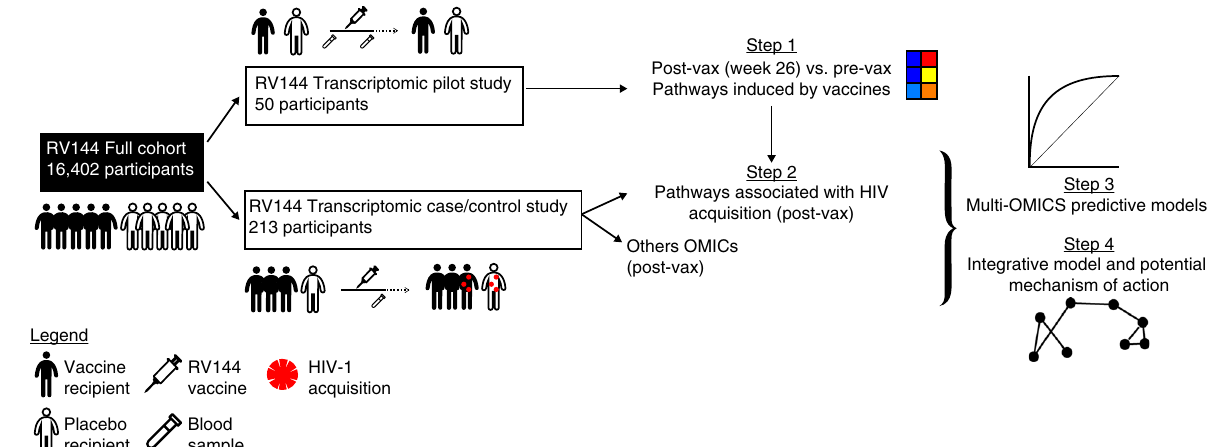
Fig. 1 Study overview. Four analysis steps were used to identify transcriptomic markers of risk of HIV-1 acquisition among RV144 vaccinees. A fi rst transcriptomic dataset of blood collected from 40 HIV-1 negative vaccinees and 10 HIV-1 negative placebo recipients prevaccination and 2 weeks after vaccination was used to identify pathways modulated by the RV144 vaccine (step 1). A second independent transcriptomic dataset of blood collected from 183 case – control vaccinees (including 31 infected participants) and 30 placebos (including 17 infected participants), 2 weeks after vaccination was used to identify pathways associated with HIV-1 acquisition. Logistic regression was used to build a multi-OMICS classi fi er of HIV-1 acquisition among